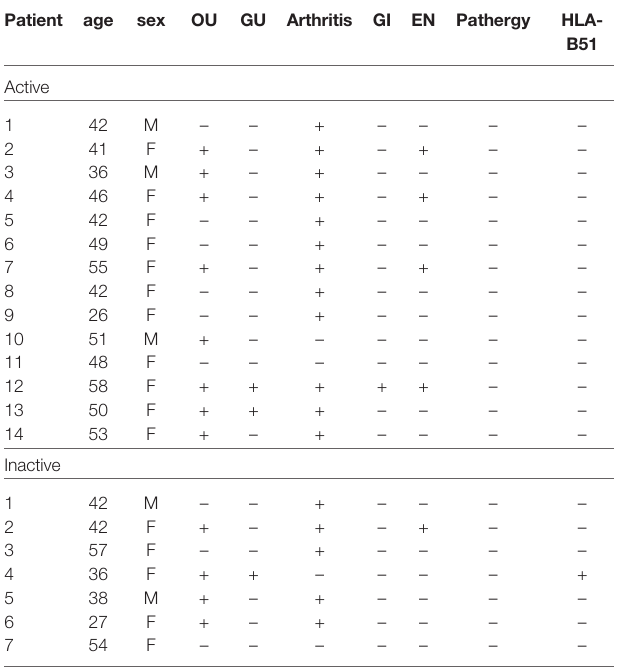
TABLE 1 | Clinical characteristics of the Behc ̧ et ’ s disease